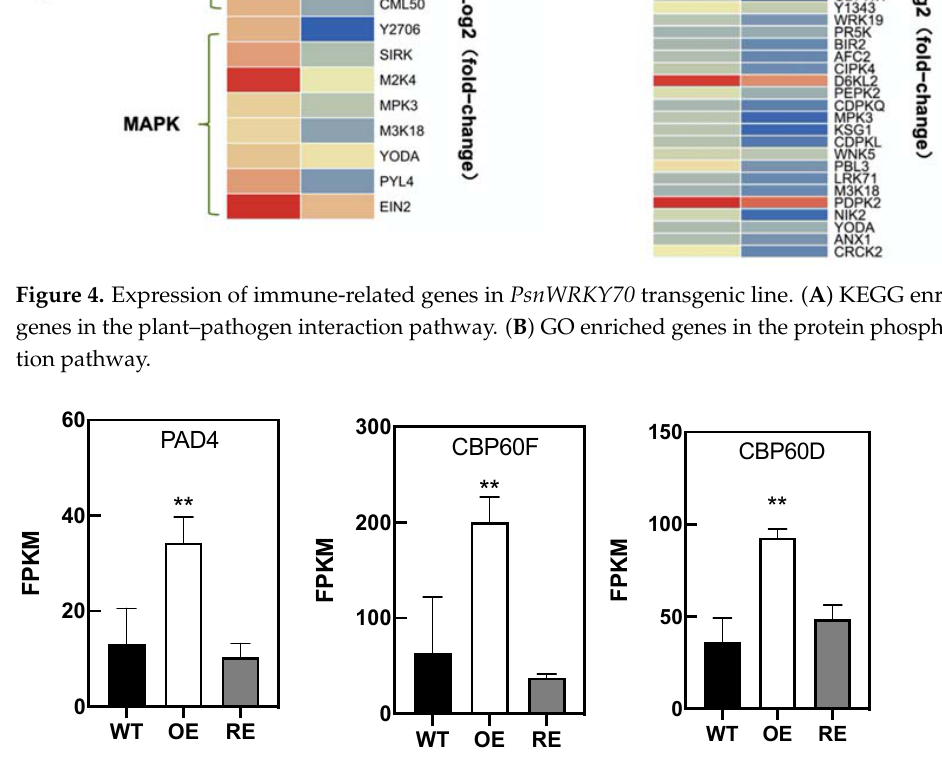
Figure 5. Expression of SA-related genes in PsnWRKY70 transgenic poplar ( n = 3, ** p < 0.01).